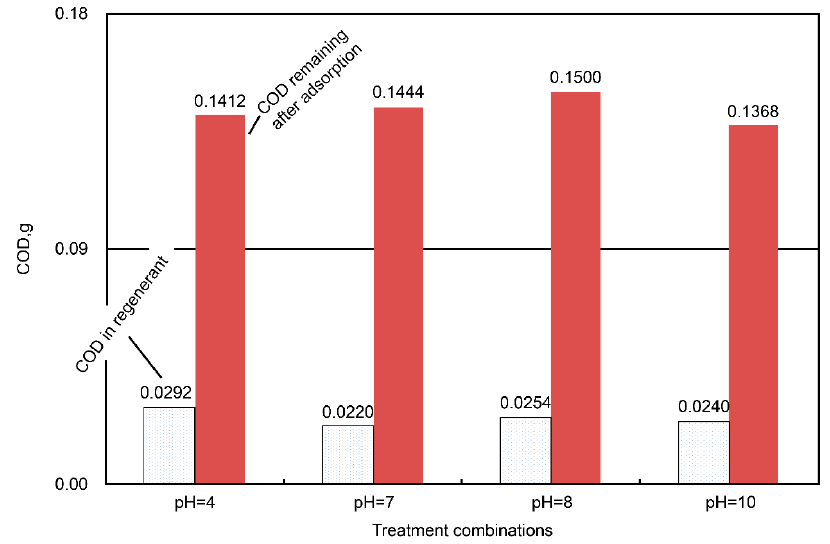
Figure 6. Plots of the COD residues (by weight) in the regenerant and the amounts of the remaining COD in the AC-treated wastewater under various regenerative pH conditions at ambient temperature. The variation of the pH showed little effect on the AC regeneration.